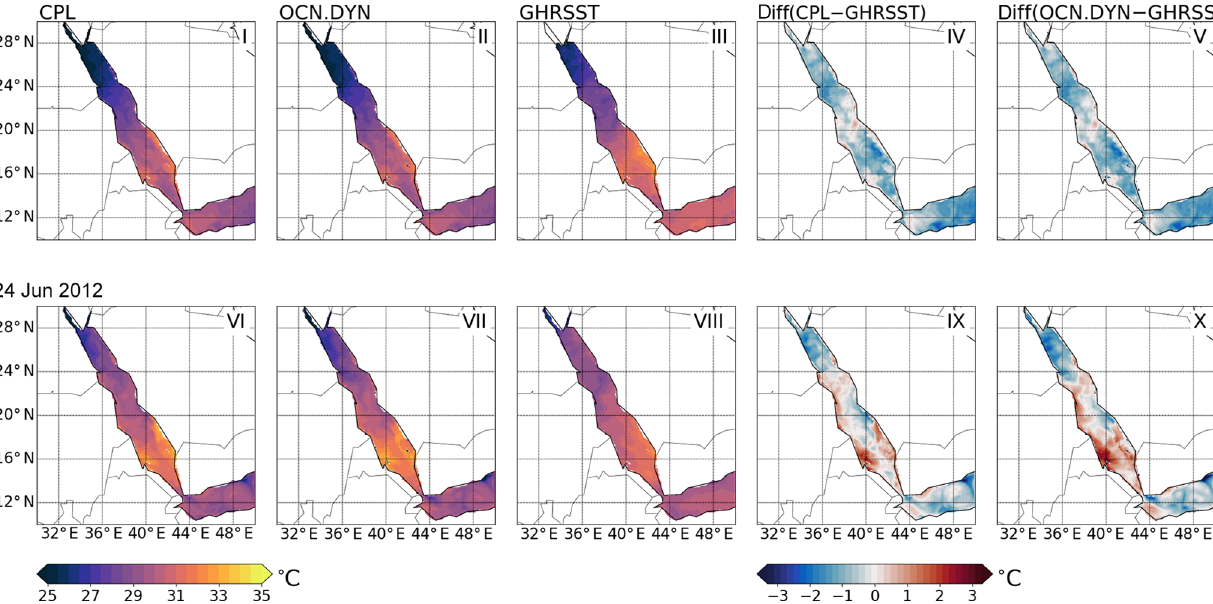
Figure 8. The SST in CPL, OCN.DYN, and GHRSST. The corresponding differences between the simulations and GHRSST are also plotted. Two snapshots of the model outputs are selected: (1) 00:00UTC 2 June 2012 and (2) 00:00UTC 24 June 2012. The simulation initial time is 00:00UTC 1 June 2012 for both